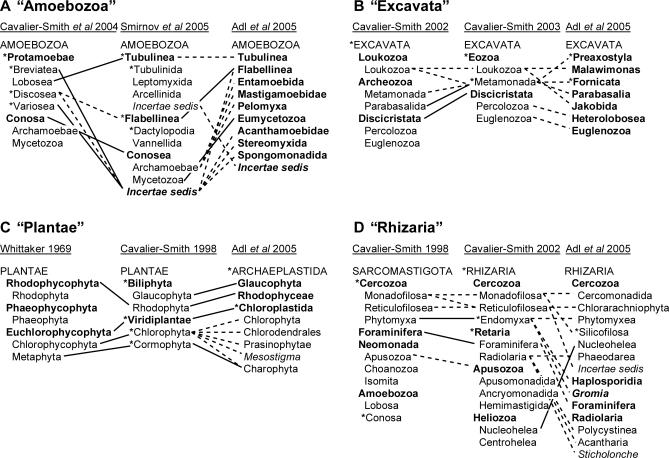
Trends in Supergroup TaxonomyA comparison of three formal classifications illustrates trends within (A) “Amoebozoa” [7,45,47]; (B) “Excavata” [7,33,60]; (C) “Plantae” [2,6,7]; and (D) “Rhizaria” [6,7,33]. A majority of solid, horizontal lines would indicate temporal stability of supergroup classification. For visual simplicity we do not indicate groups newly included in the supergroups or taxonomic restructuring within subgroups. Asterisk indicates a newly introduced term. “Chromalveolata” and “Opisthokonta” are not included because only one formal taxonomy exists for both groups. See Figure 1 for further notes.